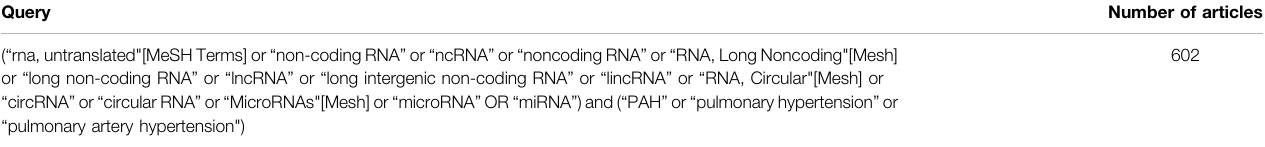
TABLE 1 | Query for searching articles from PubMed. Query Number of articles